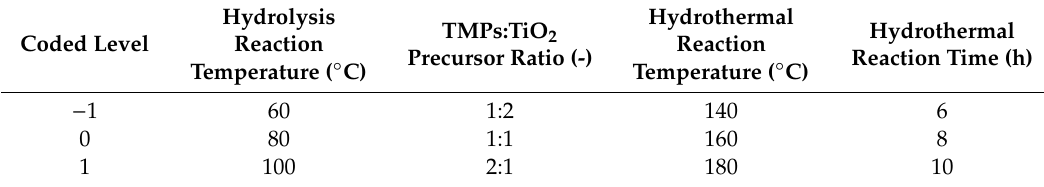
Table 2. Levels and codes of variables chosen for the experimental design.